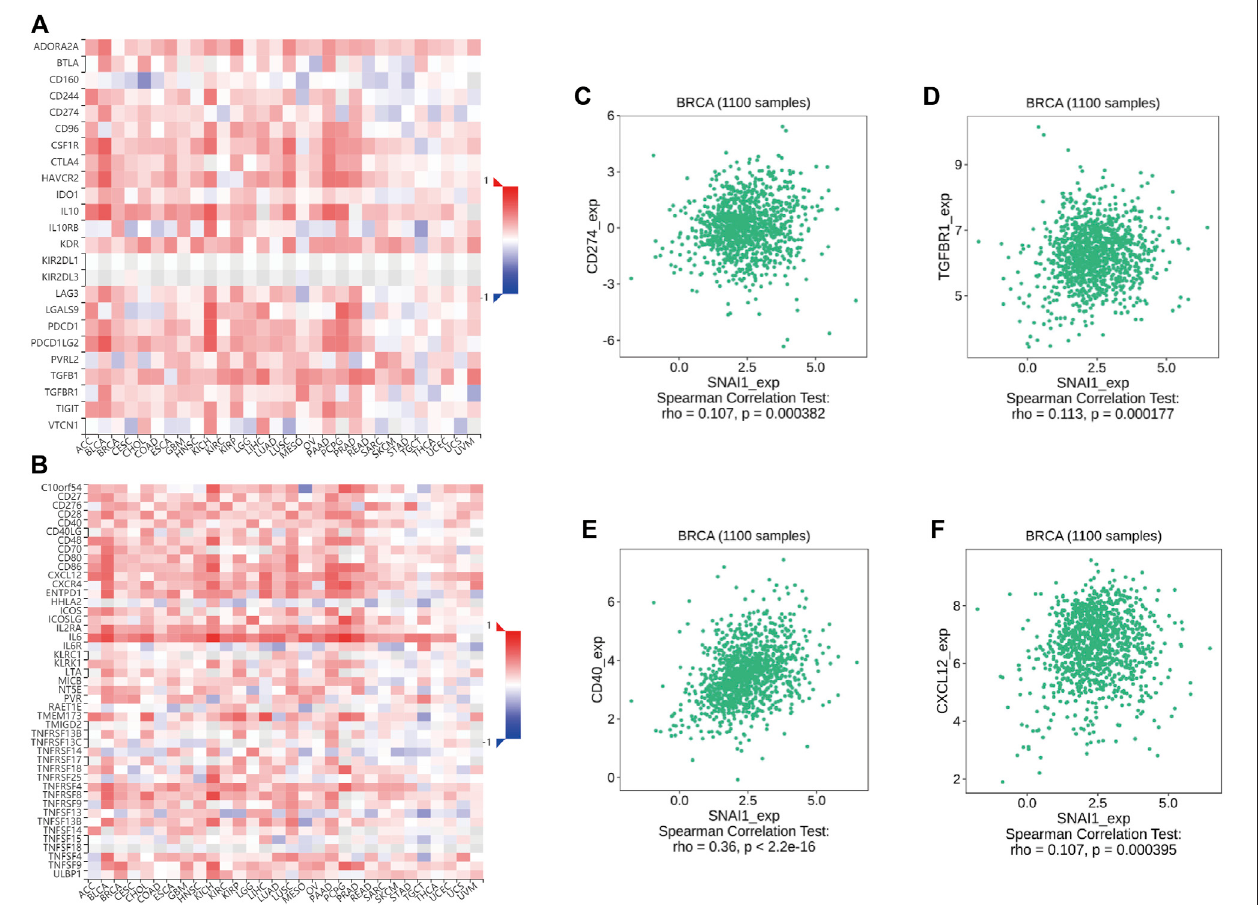
FIGURE 7 | Correlations between differentially expressed SNAI1 and the expression levels of immuno-inhibitors and immunostimulators in breast cancer (A) Correlations between SNAI1 expression levels in various cancer types and various immuno-inhibitors are shown in heatmaps. Correlations between SNAI1 expression levelsandtheexpressionlevelsof (B) CD274and (C) TGFBR1inbreastcancerareshown (D) CorrelationsbetweenSNAI1expressionlevelsinvariouscancertypesand immunostimulatorsareshowninheatmaps.CorrelationsbetweenSNAI1 expressionlevelsandtheexpression levelsof (E) CD40and (F) CXCL12inbreastcancer are